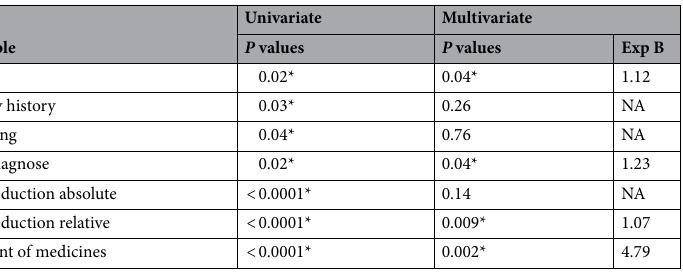
Table 3. Significant variables tested in the univariate and the multivariate logistic regression analysis using the GPA (dichotomous: progress/no progress) as endpoint. (*) Significant values. GPA Guided progression analysis; VA visual acuity; IOP Intraocular pressure; NA